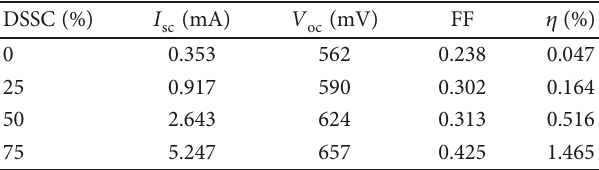
Figure 9: DSSC I - V curve. Table 2: Comparison of DSSC performance